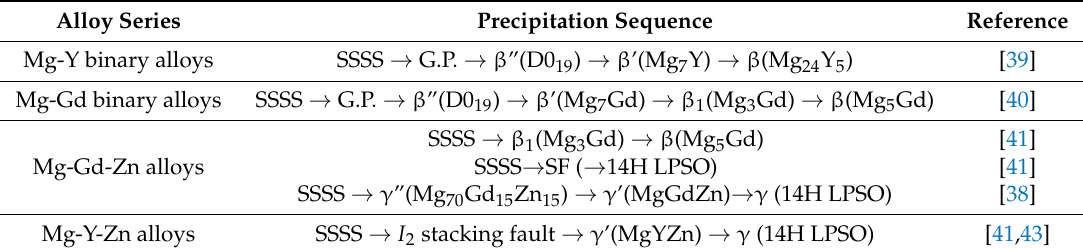
Table 1. Comparisons of precipitation sequences in typical Mg-RE based